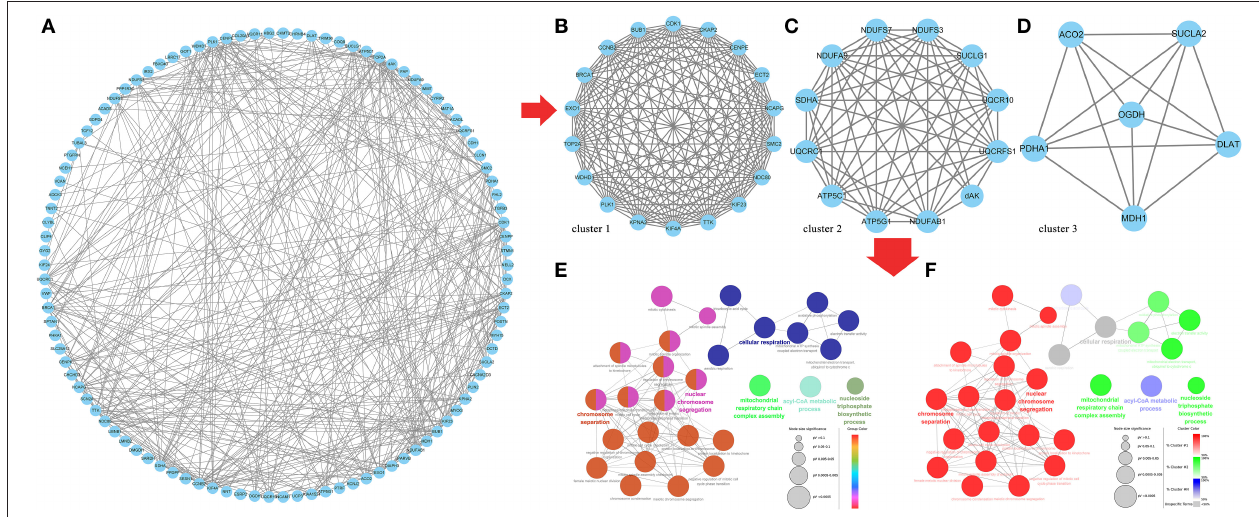
FIGURE 7 | Core genes identification and functional analysis for the same targeted DE genes in F14vsF20 and S14vsS20. (A) Protein-protein interaction network for the same targeted DE genes; (B) The core network 1(cluster 1) analyzed by MCODE; (C) The core network 2 (cluster 2) analyzed by MCODE; (D) The core network 3 (cluster 3) analyzed by MCODE; (E) Functional analysis of biological processes for the genes in the three core networks; (F) Functional analysis of biological processes for the genes in each core